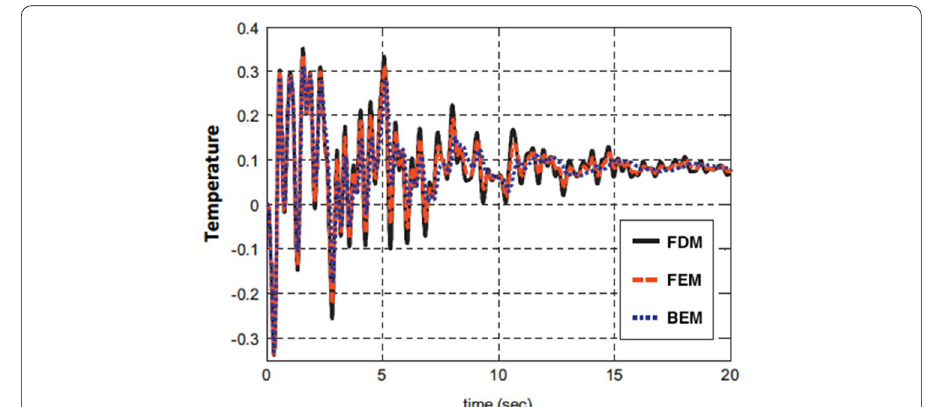
Fig. 9 Variation of the nonlinear temperature with time τ for FDM, FEM and BEM